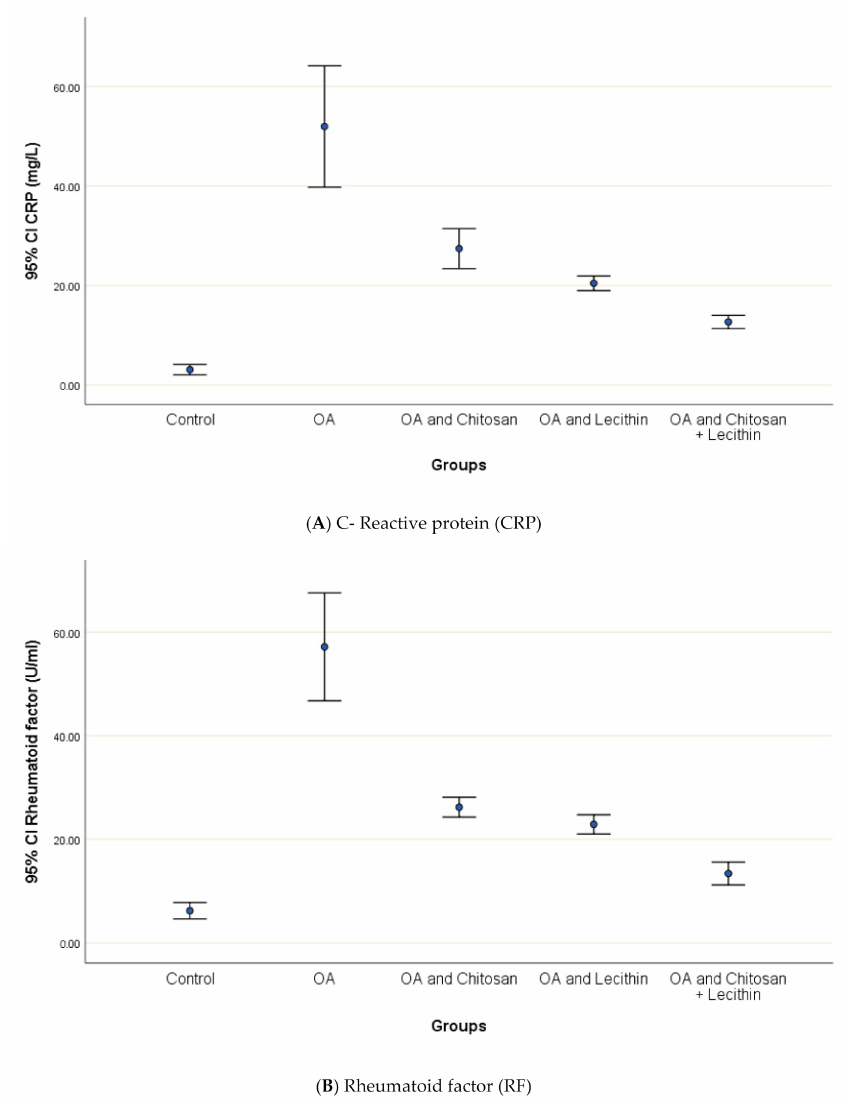
Figure 4. The efficacy of chitosan and lecithin against: ( A ) C-reactive protein (CRP) and ( B ) rheumatoid factor (RF) of (OA) model that was induced by monoiodoacetate (MIA). The data presented as mean ± S.